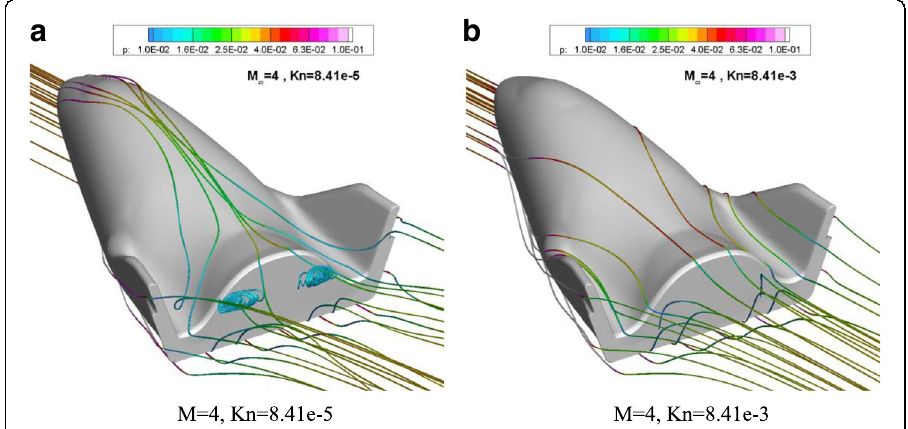
Fig. 28 Spatial streamlines around the X38-like vehicle ( a ) M = 4, Kn = 8.41e-5 (b ) M = 4, Kn =